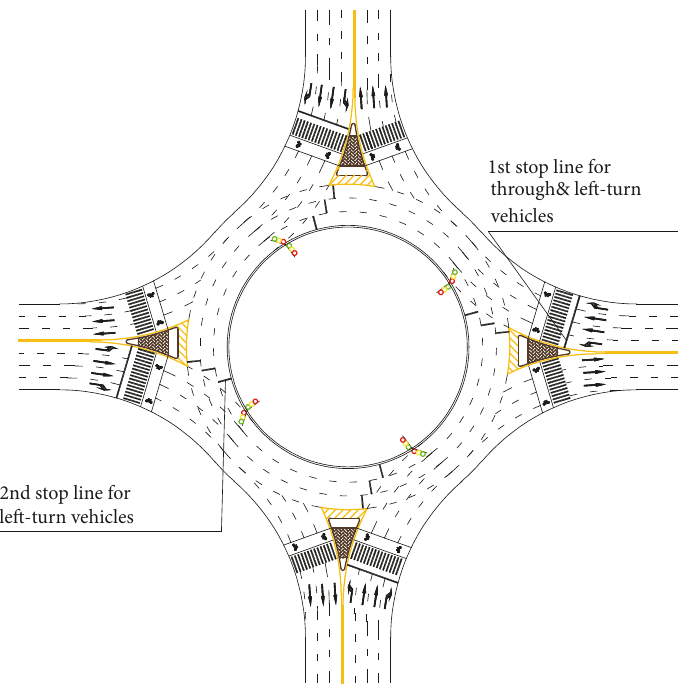
Figure 3: The typical geometric layout of a